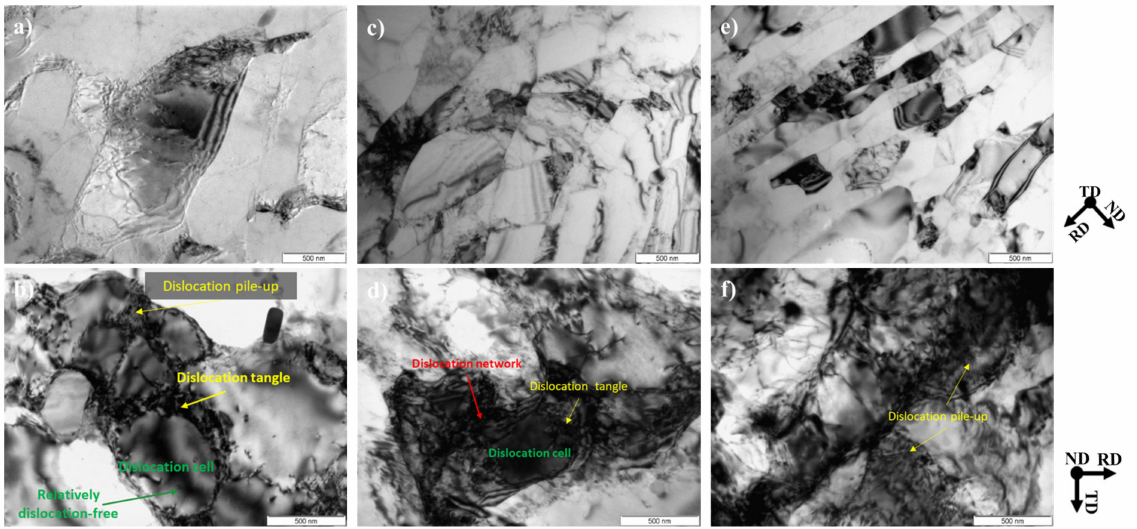
Figure 3. Representative TEM bright images of cold-rolled AA3003 aluminum alloy with different amounts of reduction. ( a , b ) 20%, ( c , d ) 50%, and ( e , f )